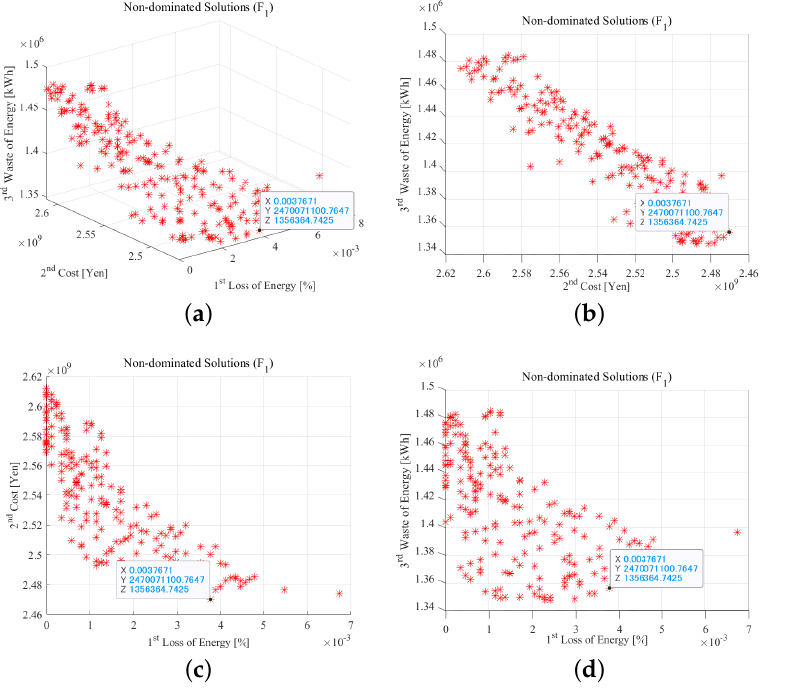
Figure 12. Pareto front results of Case 3. ( a ) 3D Pareto front; ( b ) Pareto front with LCC and WE; ( c ) Pareto front with LSPS and LCC; ( d ) Pareto front with LSPS and